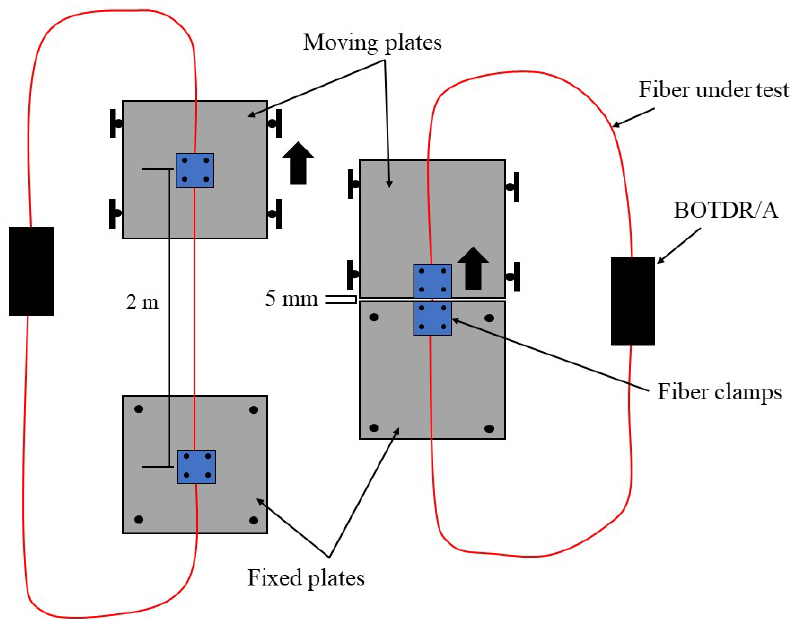
Figure 8. Elongation experimental setup for fiber optic cable comparison.